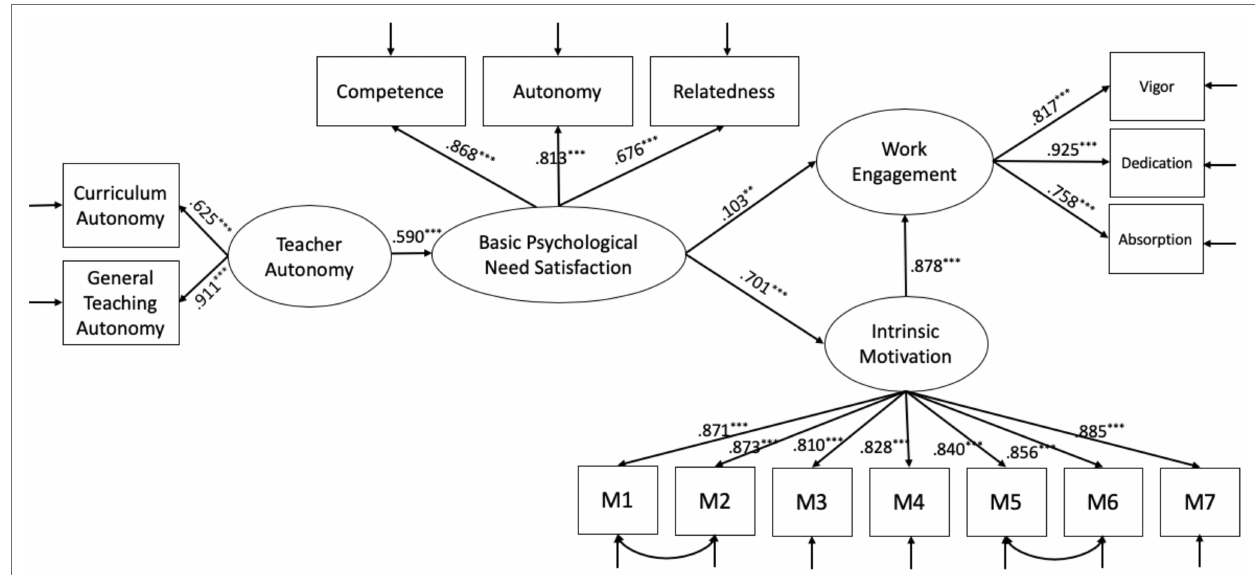
FIGURE 2 | Model of teacher autonomy and work engagement. Model fit index: χ 2 /df = 3.96; RMSEA = 0.075; CFI = 0.962 and TLI =